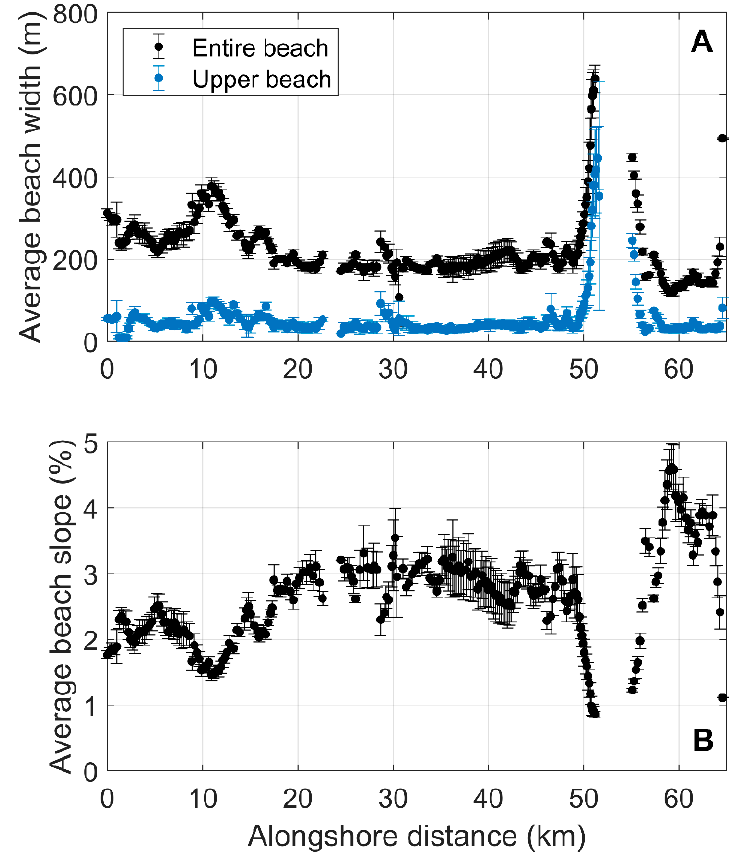
Figure 3. ( A ) Average beach width along the Belgian coast based on airborne surveys from 2000–2017. Beach width is the horizontal distance between the average low-water level and the dune foot. Upper beach width is the horizontal distance between the average high-water level and the dune foot or a hard defense structure. ( B ) Average beach slope along the Belgian coast based on airborne surveys from 2000–2017. Error bars indicate the standard deviation.